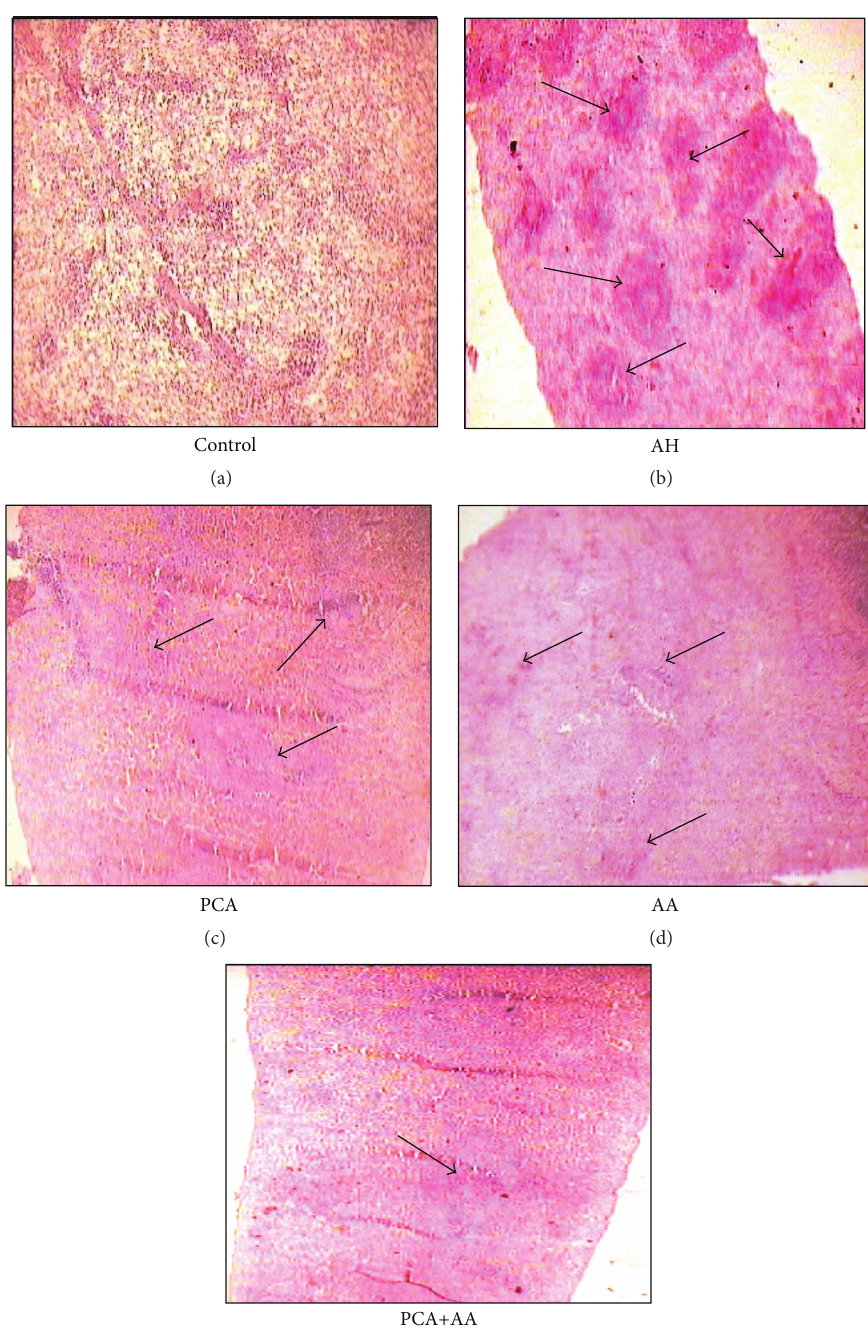
Figure 9: Histopathology of spleen stained with hematoxylin-eosin